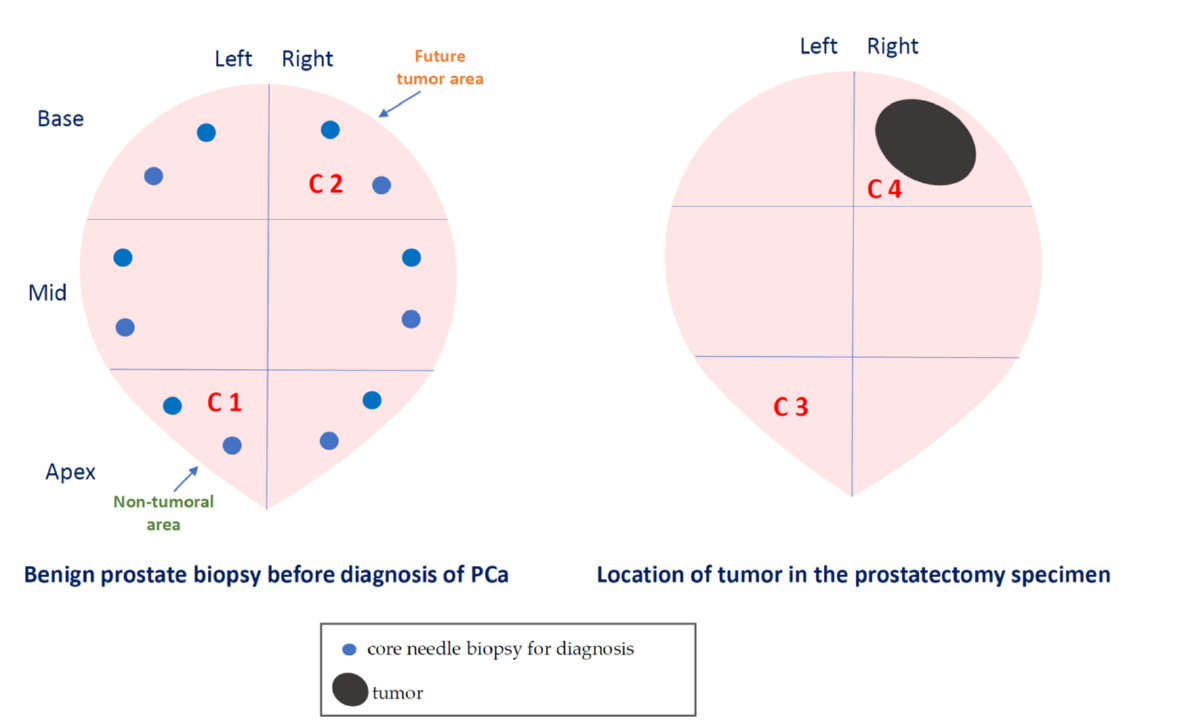
Figure 7. Schematic representation of the studied areas of the samples of patients with PCa. Protein expression (MMP-2, -9, -11, and -13, and TIMP-3 expression) were collected and grouped into different datasets depending on the analysis to be carried out. For example, pooled data from BPH (C5) or HGPIN (C6) patients with data from patients